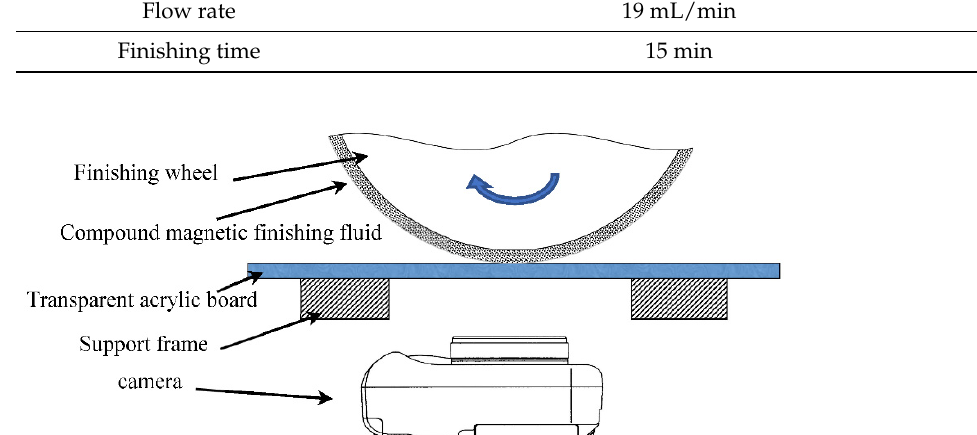
Figure 14. Schematic diagram of finishing area observation.